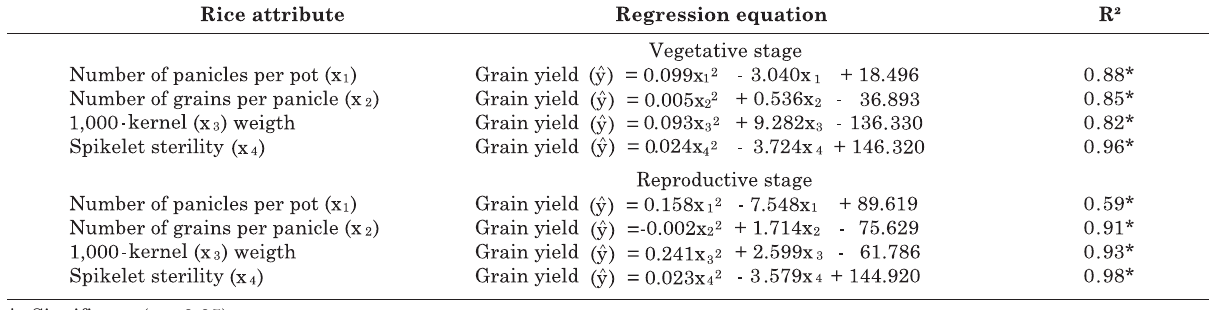
Table 1. Relation between plant attributes and grain yield in different stages of flooded rice